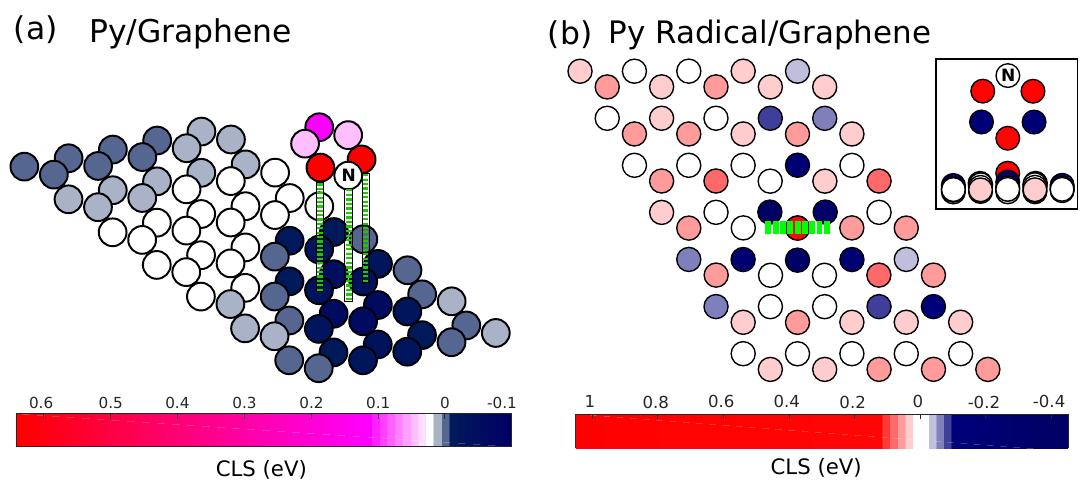
Figure 2. The Core Level Shifts (CLS) with respect to the C 1s edge of graphene is plotted for the two cases: ( a ) Pyridine/graphene and ( b ) the pyridine radical/graphene. The inset of ( b ) shows a side view centered on the